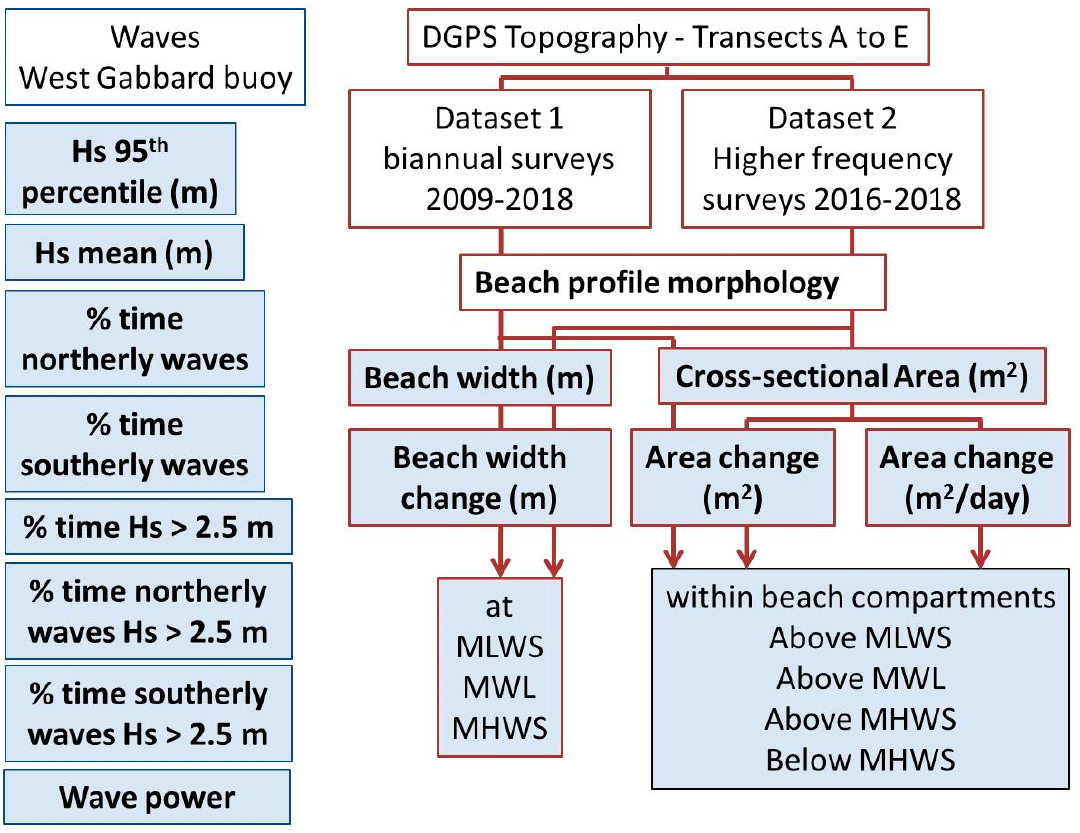
Figure 2. Schematic representation of the data collection related to topography (obtained along Transects A to E) and the wave parameters extracted from the West Gabbard Datawell Directional Waverider buoy. Shaded boxes indicate the variables used to test correlations. GDPS: Real-Time Kinematic Differential Geographical Positioning System; MLWS: mean low water springs; MWL: mean water level; MHWS: mean high water